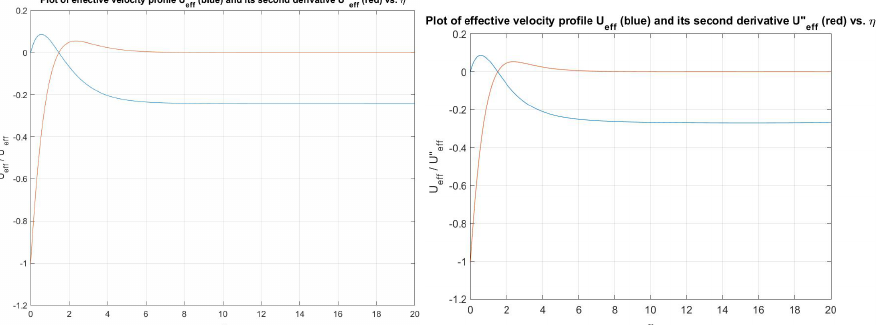
Figure 6. Plot showing the velocity effectiveness ¯¯ U (below graph at η = 20) and its second derivative ¯¯ U (cid:48)(cid:48) (above graph at η = 20) for ψ = 90 0 , T s = − 0.01 ( left ) and − 0.04 ( right ).